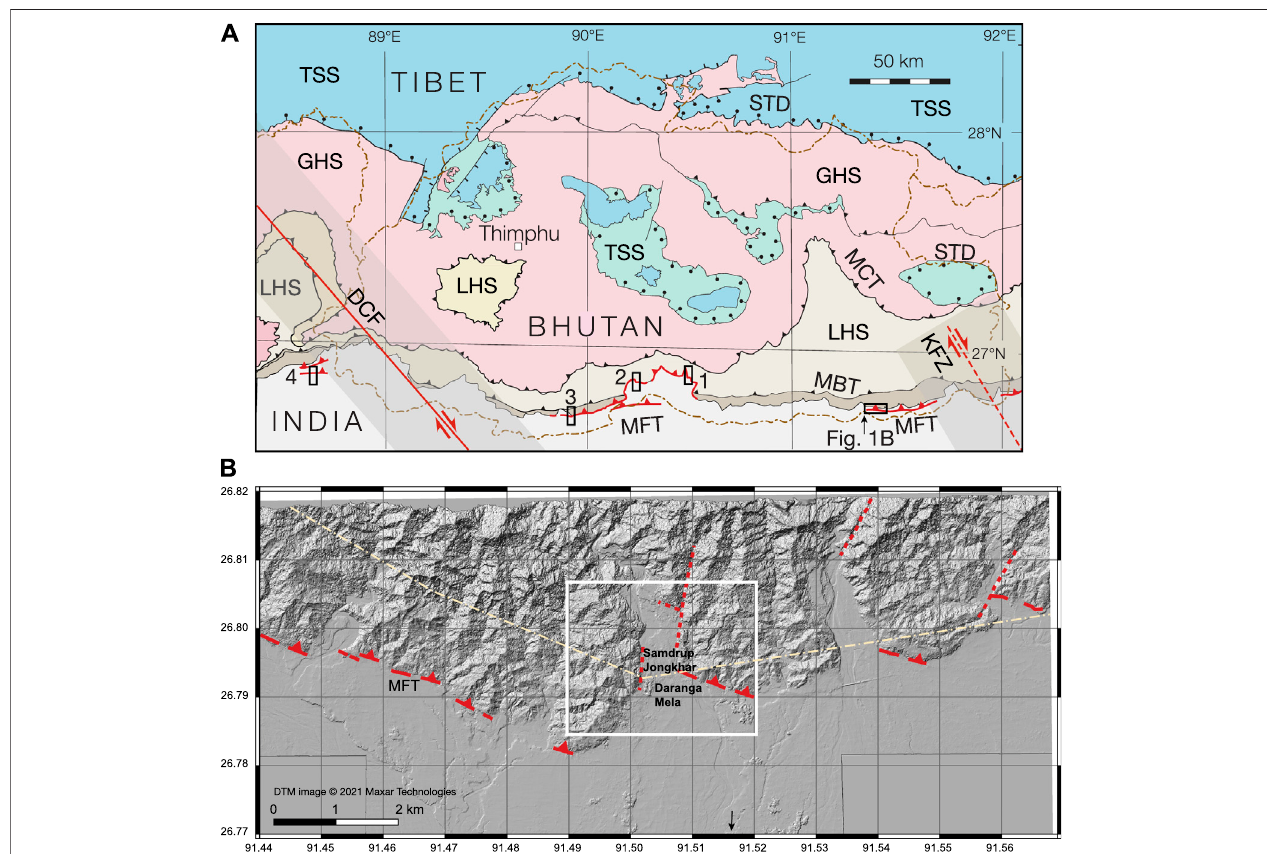
FIGURE 1 | (A) Simpli fi ed geology of the Bhutan Himalaya, with the area of Panel (B) shown with the black square in the SE corner. Previous paleoseismological studies in the area are indicated with vertical rectangles: 1 : Gelephu (Berthet et al., 2014); 2 : Sarpang (Le Roux-Mallouf et al., 2016); 3 : Piping (Le Roux-Mallouf et al., 2020); 4 :Chalsa(Kumaret al.,2010).STD:South TibetanDetachment;MCT:MainCentral thrust;MBT:Main Boundary Thrust;MFT:Main FrontalThrust;TSS:Tethyan Sedimentary Sequence; GHS: Greater Himalayan Sequence; LHS: Lesser Himalayan Sequence. DCF : Dhubri – Chungthang fault zone (Diehl et al., 2017); KFZ : Kopili Fault zone (Sutar et al., 2017). (B) Topography of the Himalayan foothills and foreland basin in eastern Bhutan. The Himalayan Frontal Thrust consists of an en échelon arrangement of short segments. White square indicates the area of Figure 2 . The digital terrain model (DTM) with a horizontal resolution of 0.5 m and vertical resolution of 8 m was derived from Maxar stereo pair imagery by Maxar Technologies and further processed using QGIS (v. 3.16.3).